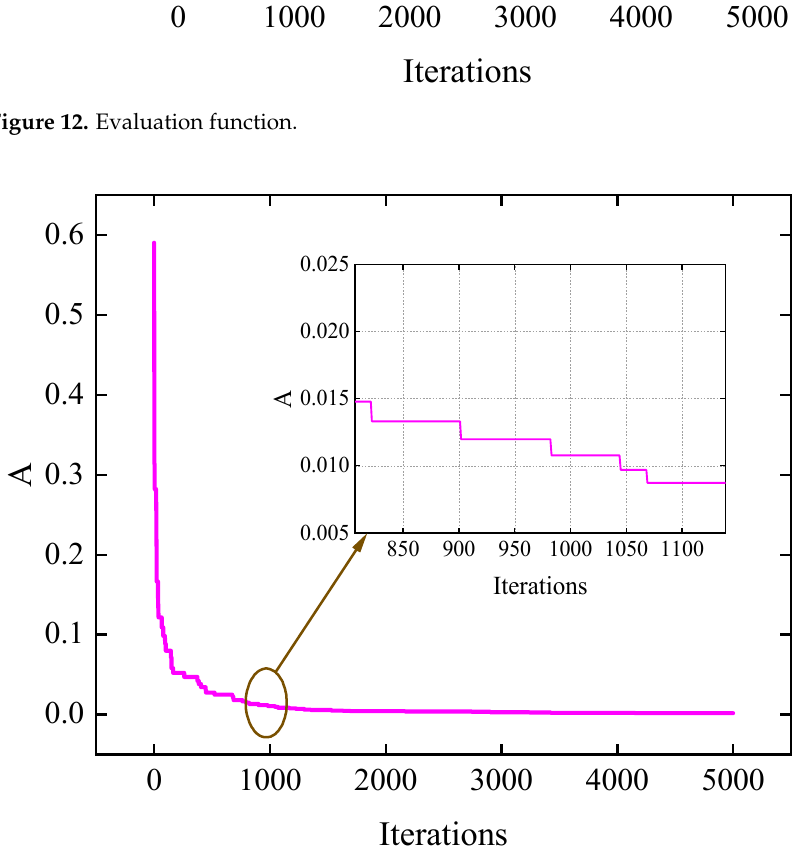
Figure 13. Impulse Figure 13. Impulse loudness.